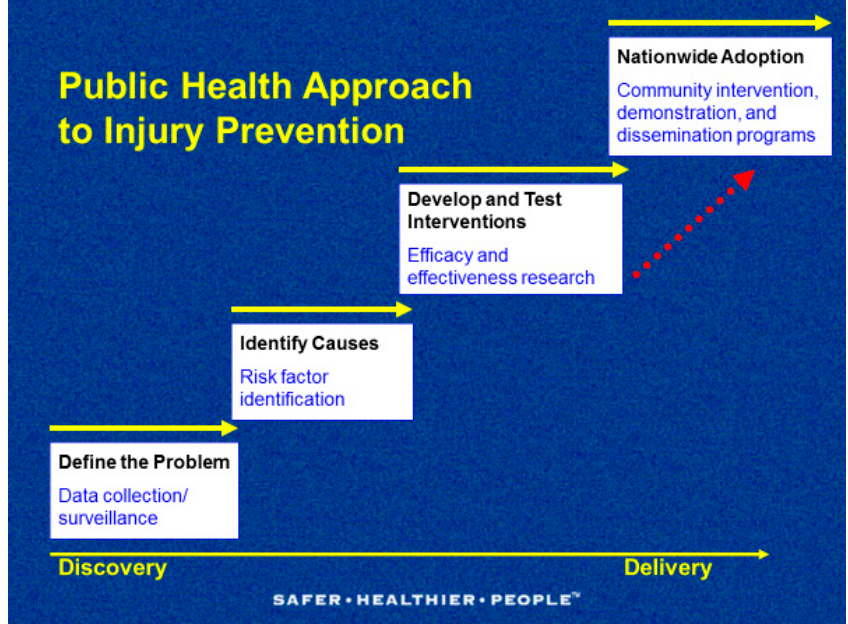
Figure 1. The public health approach to injury prevention. Source: National Center for Injury Prevention and Control, U.S. Centers for Disease Control and Prevention (CDC).